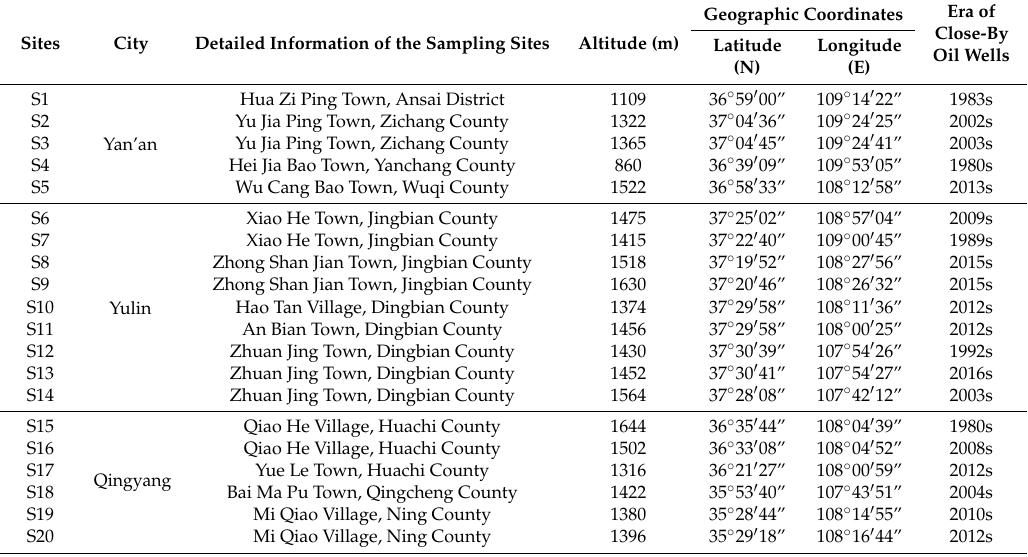
Table 1. Basic information of the sampling sites in this